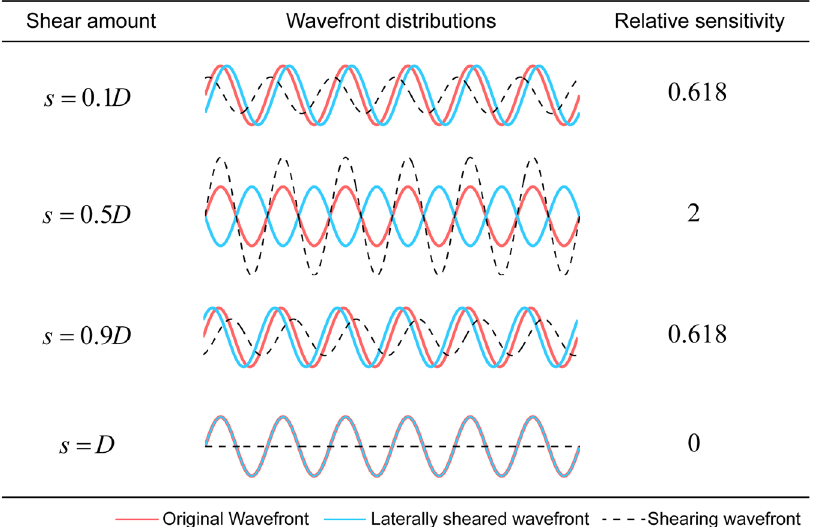
Figure 2. One-dimensional measurement sensitivity of lateral shearing interferometry relative to that of an interferometer with external reference. The relative sensitivity of lateral shearing interferometry ranges from 0 to 2 with the variation of the lateral shear amount when the wavefront under test is in one-dimensional sinusoidal